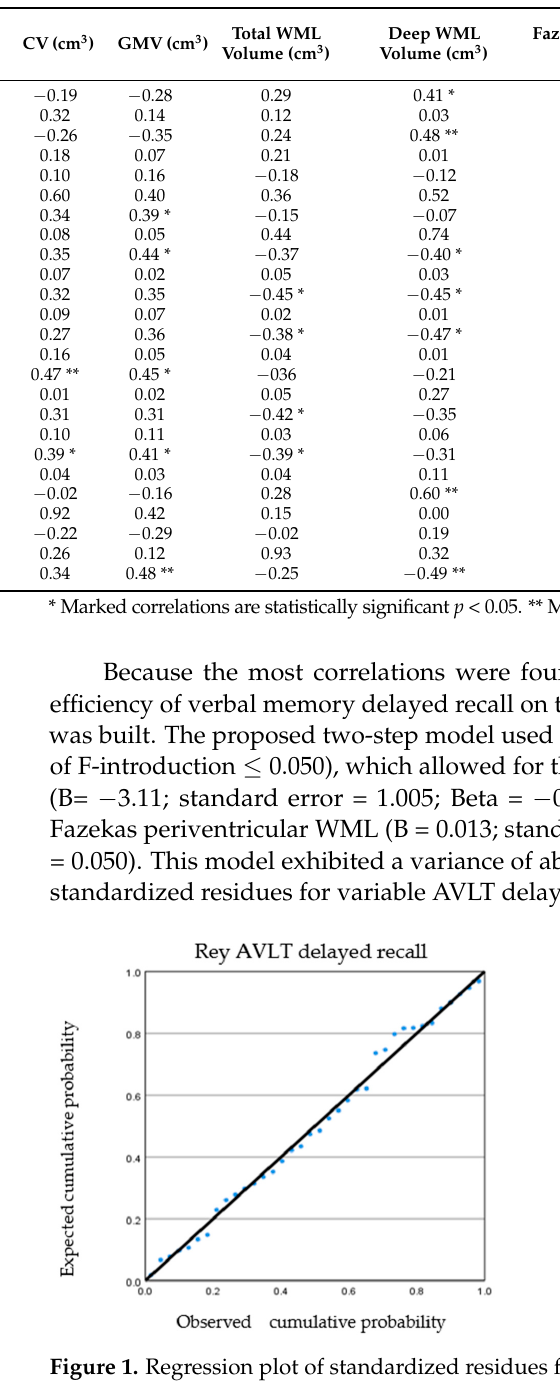
Table 4. Pearson correlation between MRI parameters and cognitive test performance in patients with psoriasis.